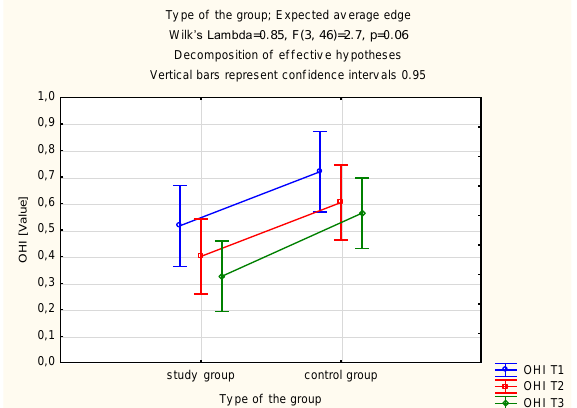
Figure 2. Estimated marginal means for the simplified oral hygiene index (OHI-s) in the study and control groups.